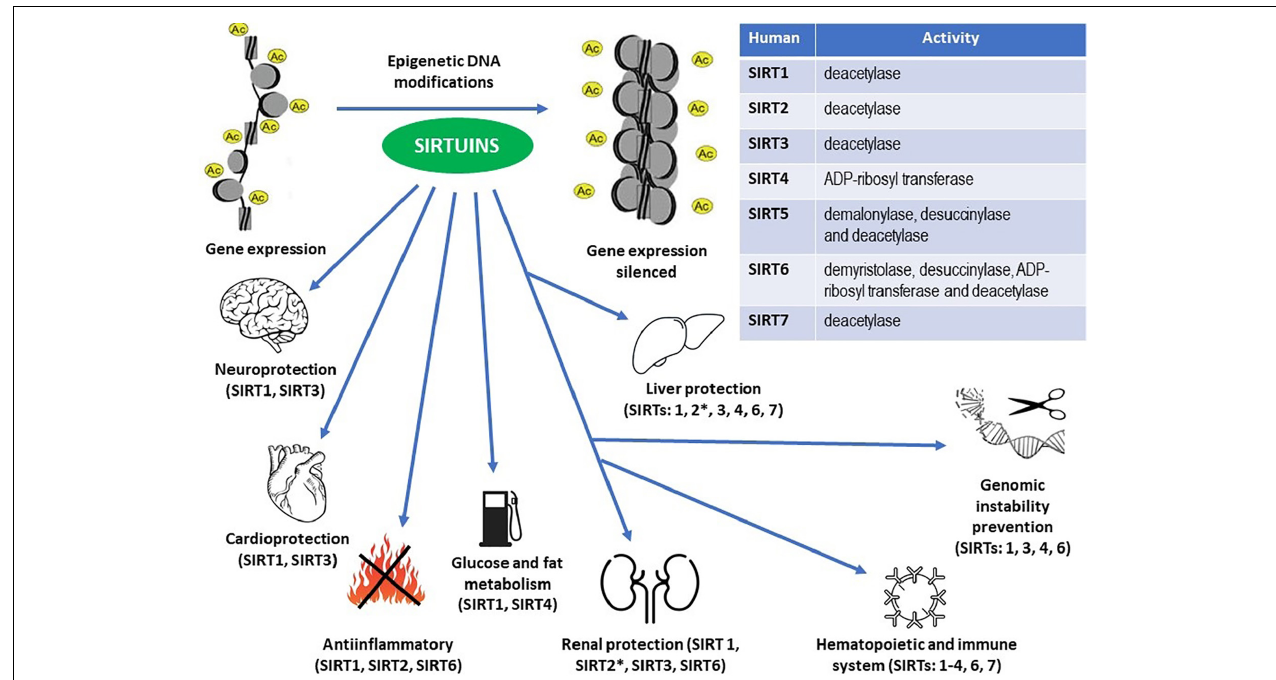
FIGURE 2 | Enzymatic activities within the sirtuin family members (Table) and epigenetic DNA modifications resulting in the proven protective effects throughout the human body (see the main text for details). ∗ Unlike other sirtuins, SIRT2 may exert pro-inflammatory actions in the kidneys and pro- inflammatory and pro-fibrotic effects in the